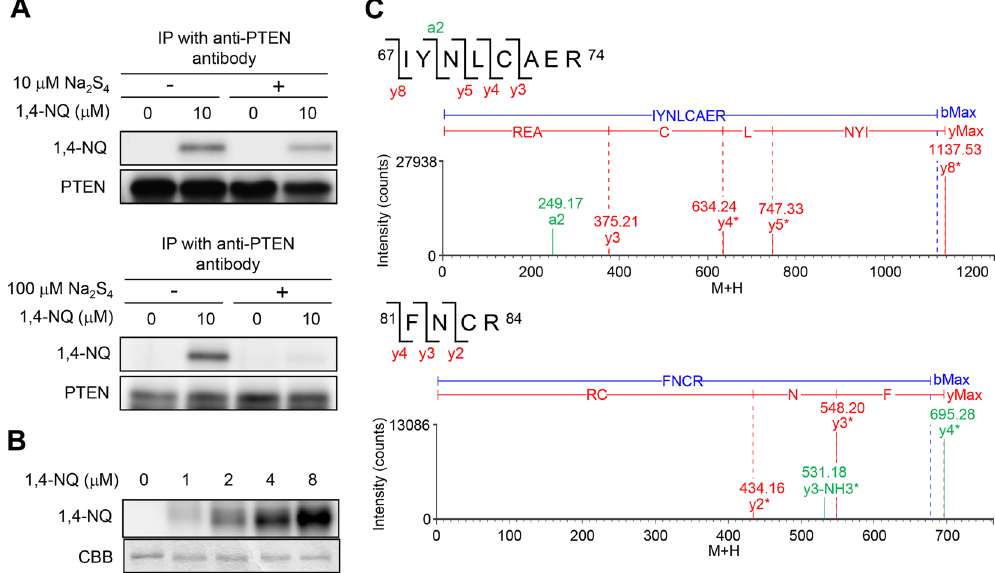
Figure 2. Chemical modification of cellular and recombinant PTEN by 1,4-NQ and suppression of 1,4-NQ modification of cellular PTEN. ( A ) Primary mouse hepatocytes were simultaneously treated with DMSO or 1,4-NQ and 10 (upper) or 100 (lower) µ M Na 2 S 4 for 30 min, then PTEN was immunoprecipitated using anti- PTEN antibody. Western blotting was performed using the indicated antibodies. Representative blots are shown from three independent experiments. ( B ) Recombinant GST-tagged human PTEN (1 μ g) was incubated with 1,4-NQ (1–8 μ M) at 25 °C for 1 h. The reaction mixture was then subjected to immunoblotting, with the anti- 1,4-NQ antibody, and SDS-PAGE, with Coomassie Brilliant Blue staining. Representative blots are shown from three independent experiments. ( C ) Results of nanoUPLC-MS E analysis of 1,4-NQ-modified cysteine residues in GST-tagged human PTEN. Recombinant GST-tagged human PTEN (1.7 μ g) was incubated with 1,4-NQ (10 μ M) at 25 °C for 30 min in a total volume of 10 μ L 50 mM Tris-HCl (pH 7.5). After the reaction, PTEN protein was digested with trypsin and analyzed by nanoUPLC-MS E . The corresponding MS E data are shown in Table